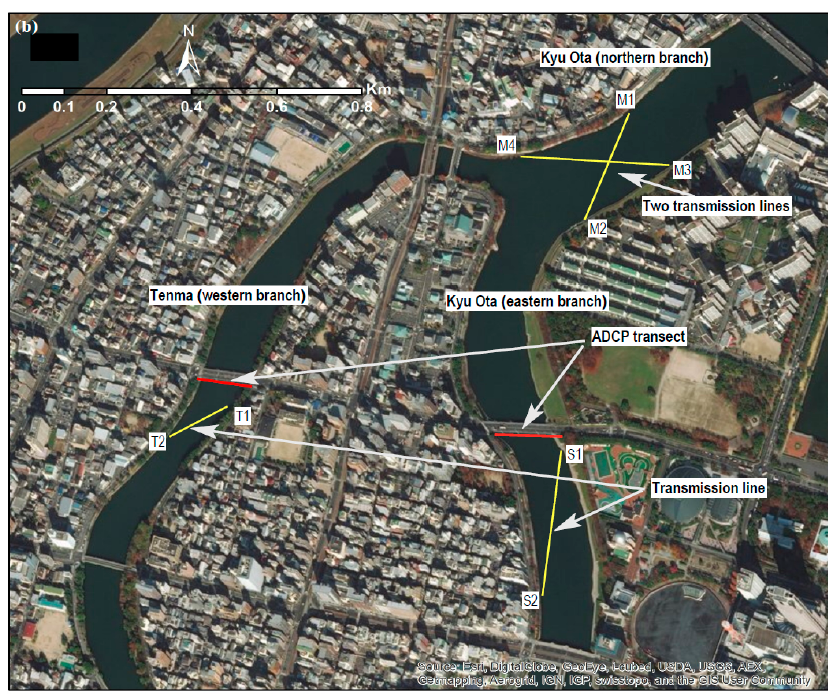
Figure 1. ( a ) Ota river channel network map. The black box denotes the study area. ( b ) Observation site and deployment of the fluvial acoustic tomography system (FATS) at the eastern, western, and northern branches. The yellow lines represent the transmission lines between the two transducers of FATS. S1–S2, T1–T2, and M1–M4 denote the locations of the transducers for FATS measurements. The red lines denote the acoustic Doppler current profiler (ADCP) transects for the comparison with FATS.